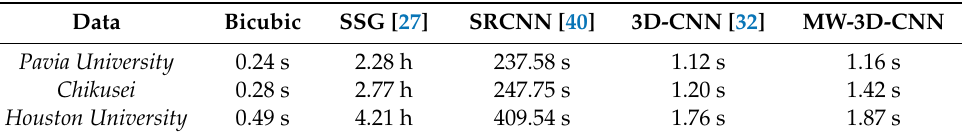
Table 4. The running time of di ff erent SR methods by an upscaling factor of four. Data Bicubic SSG